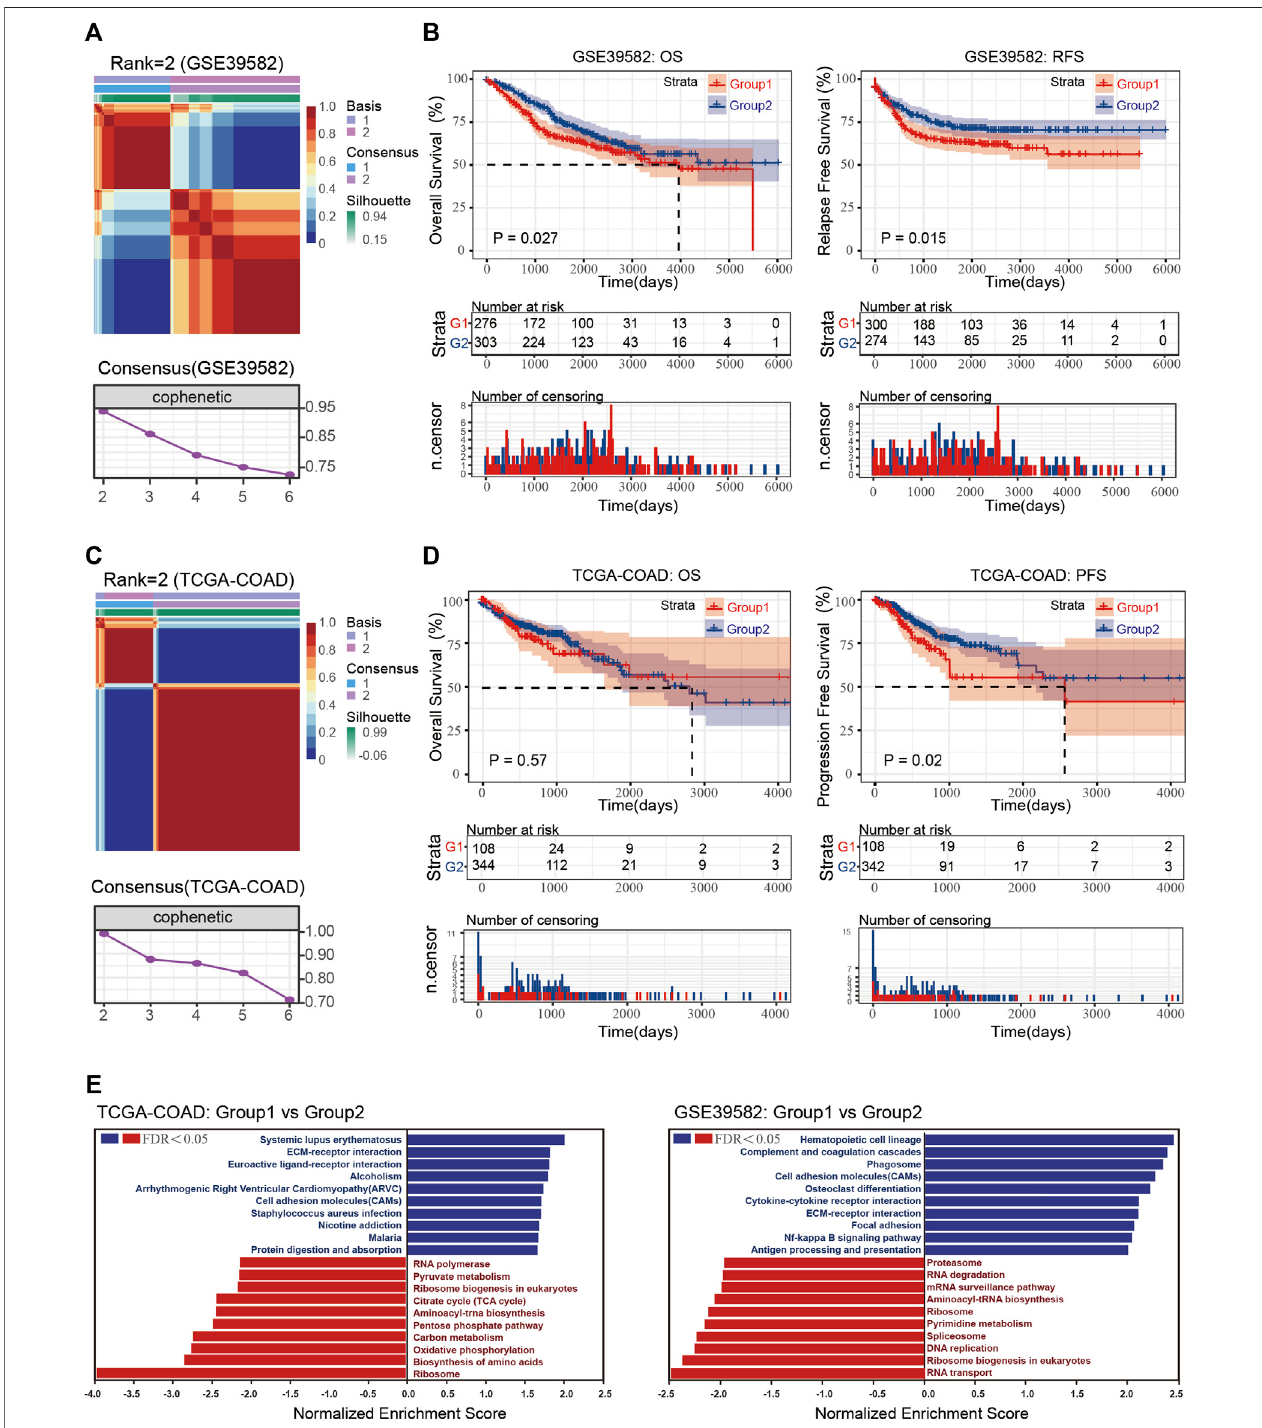
FIGURE1|(A) Consensus map andconsensusresults ofGSE39582 withrank=2. (B) Overallsurvival(OS)and recurrence-freesurvival(RFS)ofthedormantand proliferous subgroups in GSE39582. (C) Consensus map and consensus results of TCGA-COAD with rank = 2. (D) OS and RFA of the dormant and proliferous subgroups in TCGA-COAD. (E) GSEA results of Group 1 vs. Group 2 in TCGA-COAD and GSE39582.